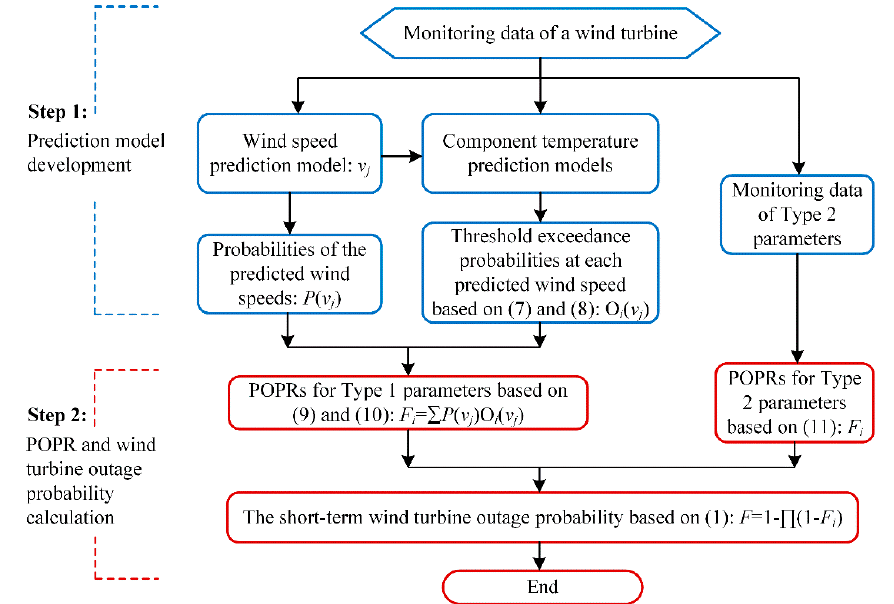
Figure 14. Flowchart of the short ‐ term WT outage probability prediction.